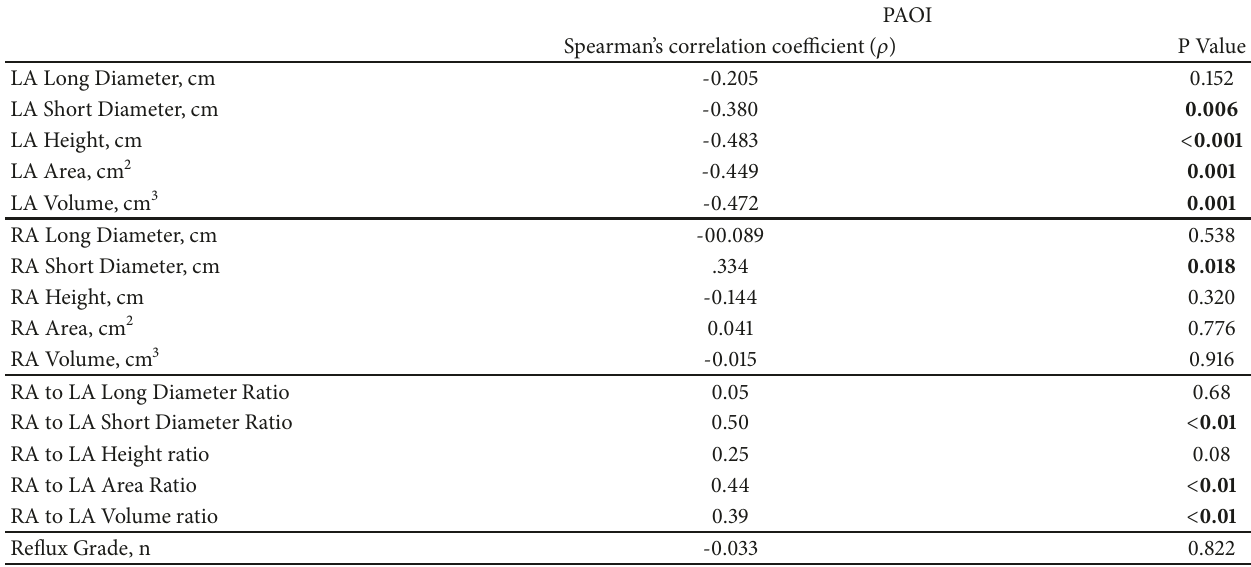
Table 2: Correlation between PAOI and radiologic parameters in computed tomography (CT)